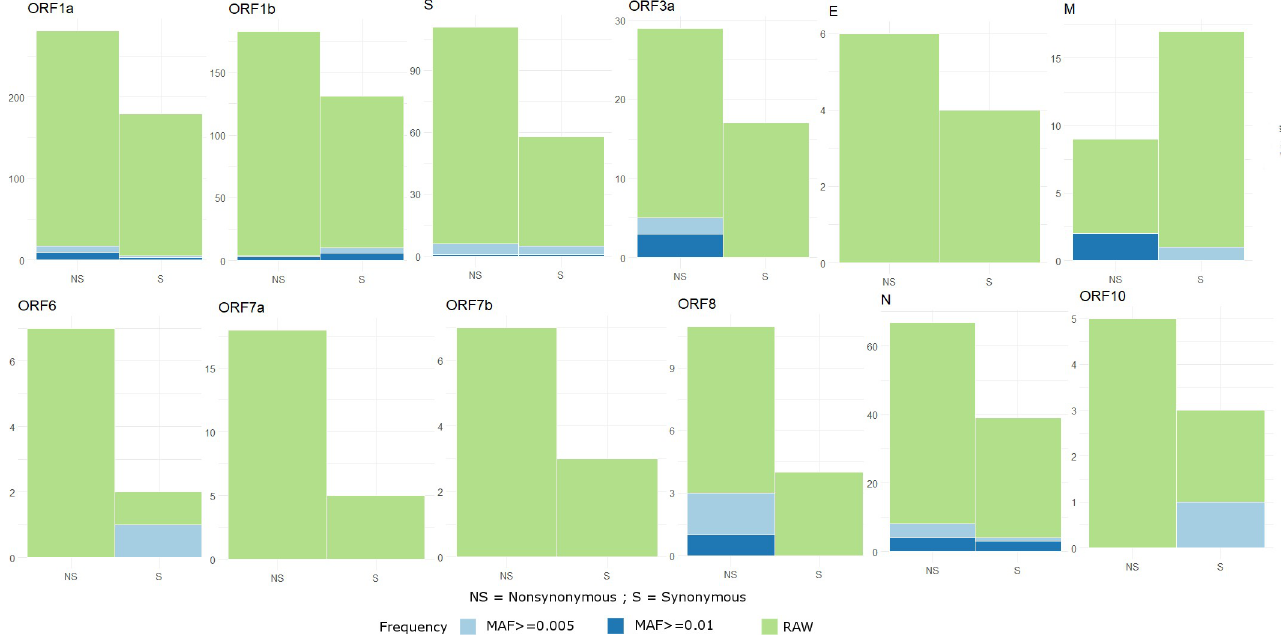
Fig 1. Detection and classification of mutations from GISAID SARS-CoV-2 genome sequences. Illustration of the distribution of synonymous and nonsynonymous variants for each gene in the raw dataset, MAF � 0.5%, and MAF � 1% thresholds are shown. A set of 72 variants in total was observed with MAF � 0.5% threshold and utilized in subsequent analysis. MAF- Minor Allele